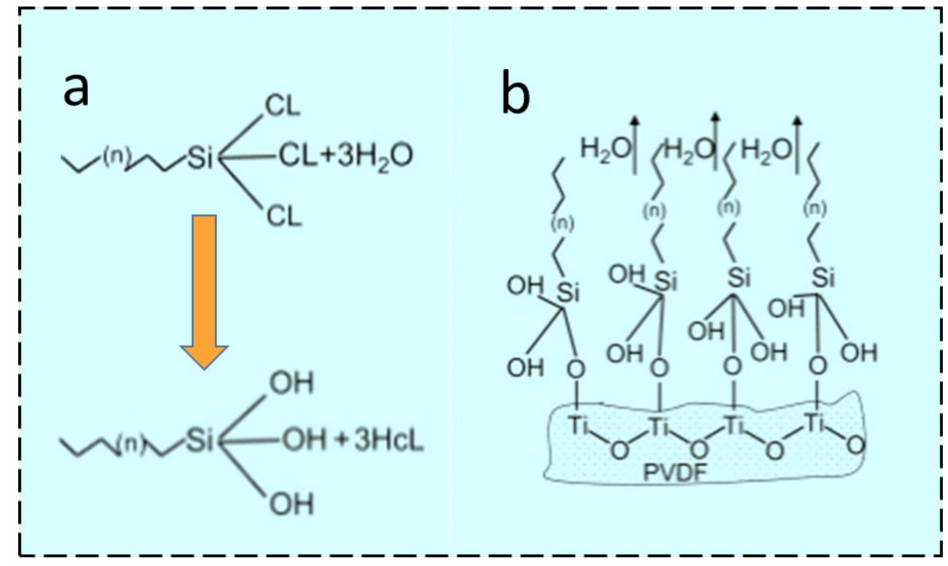
Figure 4. Scheme for the salinization of PVDF by ( a ) hydrolyzation using FTCS, or ( b ) condensation of trisilanols [107] (Reprinted with the permission License No: 5497580436300 14 Febuary 2023, Elseviers).